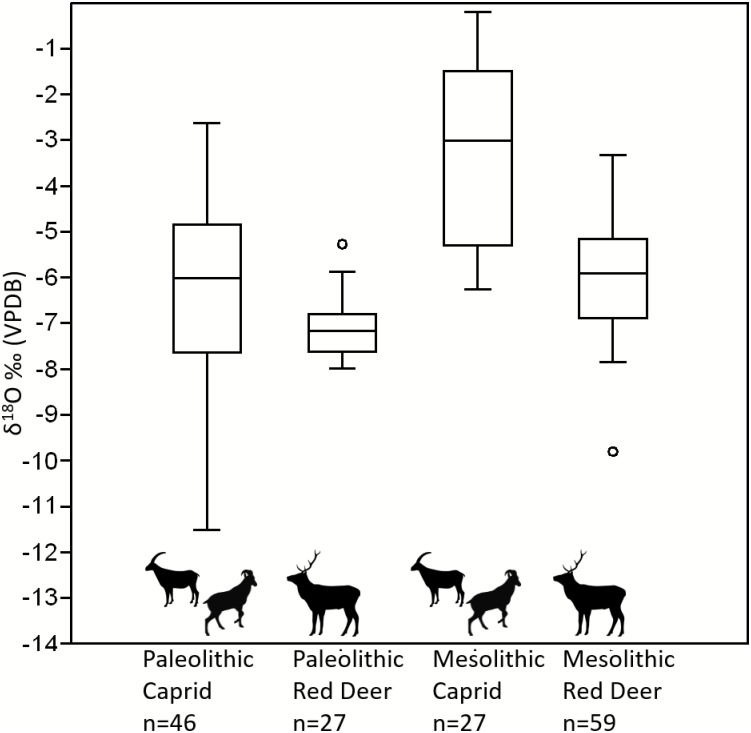
Boxplot of δ18O values in caprids and red deer through time, where box = 50% and whiskers are 95%.